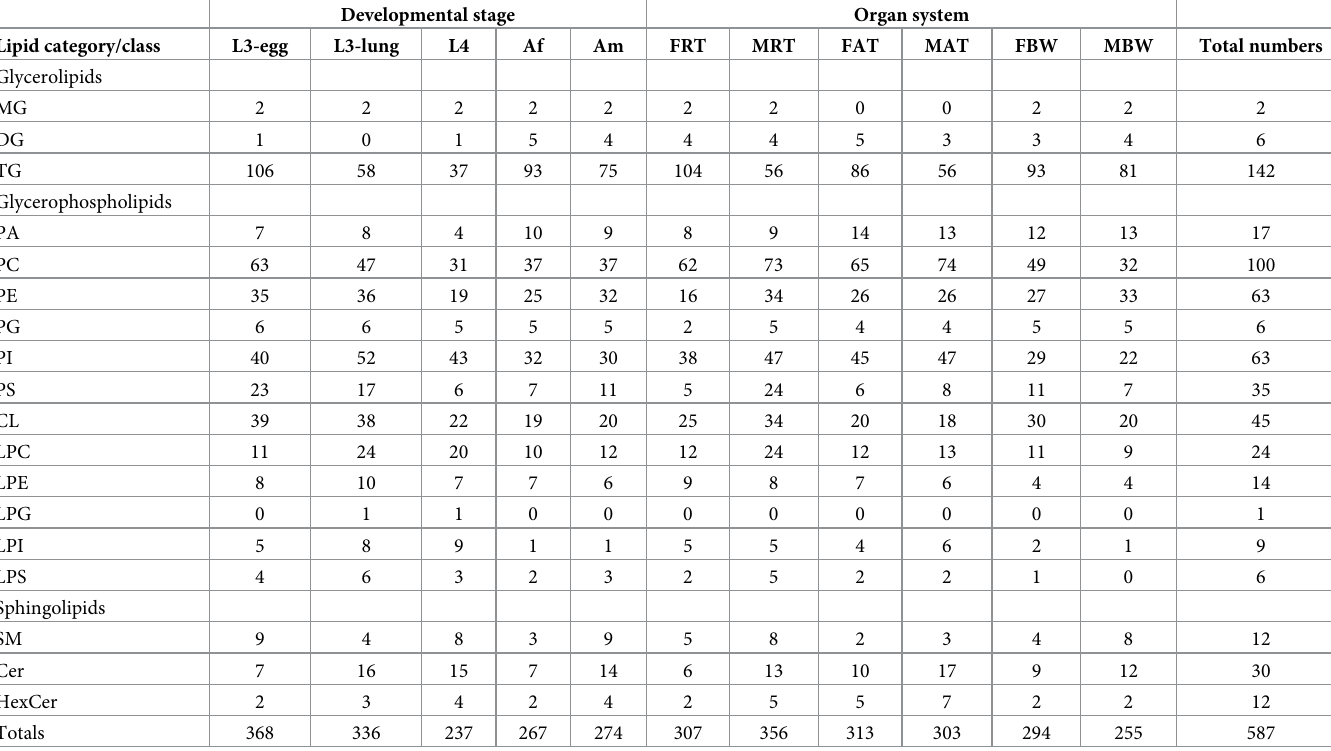
Table 1. Summary of the numbers of identified lipid species from lipid extracts derived from different developmental stages or organ systems of Ascaris suum . Developmental stage Organ